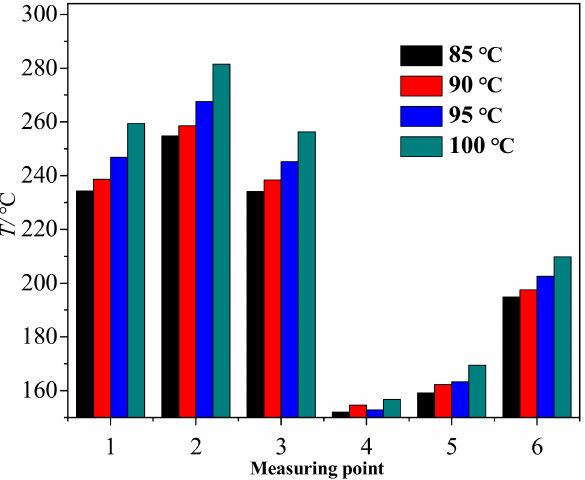
Figure 6. Effects of cooling-water inlet temperature on the